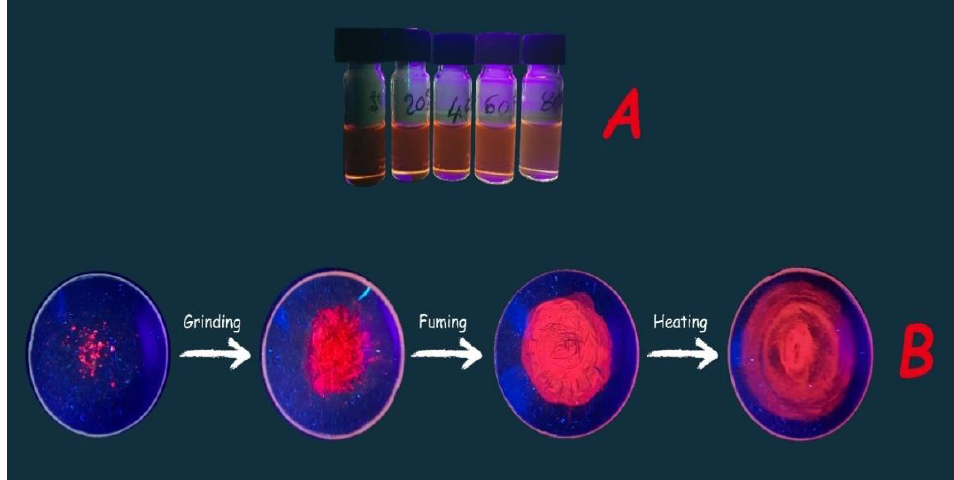
Figure 3. Above ( A ): Emission (under 365 nm UV-vis lamp) of NBDF TCE/hexane solutions upon incremental addition of hexane to the TCE sample (0%, 20%, 40%, 60% and 80%, respectively). Below ( B ): A sample of as-synthetized NBDF (first petri dish), photographed after grinding, fuming and heating process (second, third and fourth sample, respectively).